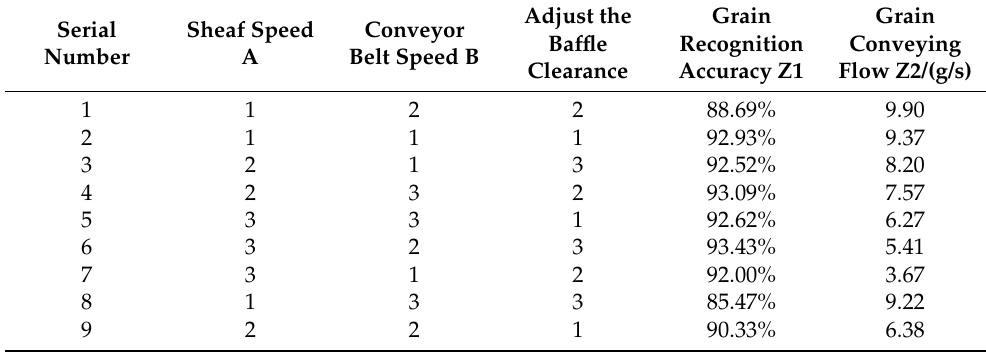
Table 2. Test scheme and results.